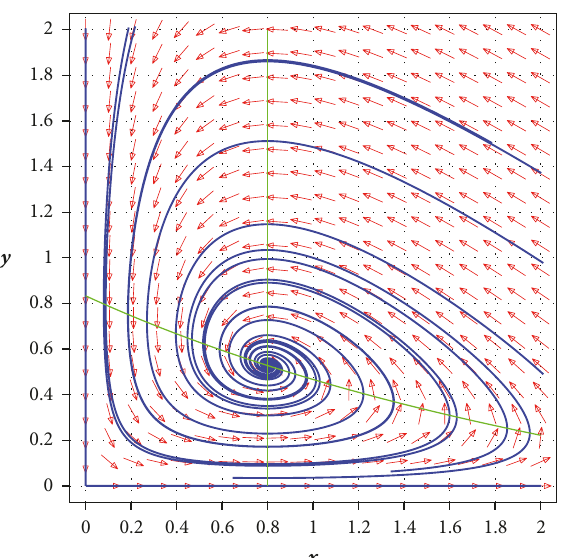
Figure 1: The phase diagram of system (7) with 𝑚 = 1 , 𝑟 = 0.3 , 𝐾 = 2 , 𝑑 = 0.5 , 𝑞 = 0.6 , 𝜇 = 0.5 , and 𝑙 = 0.4 .